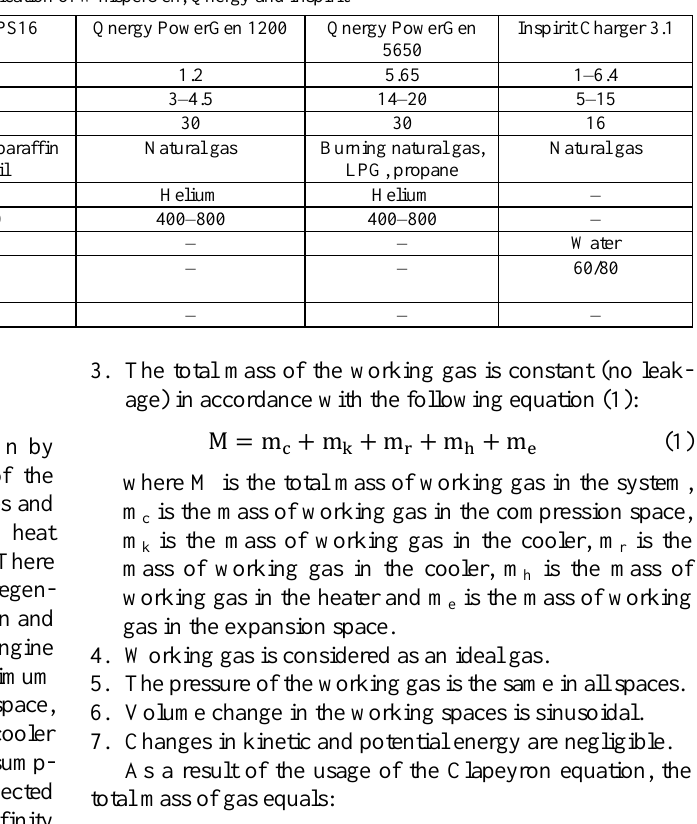
Table 2. Technical specification of WhisperGen, Qnergy and Inspirit